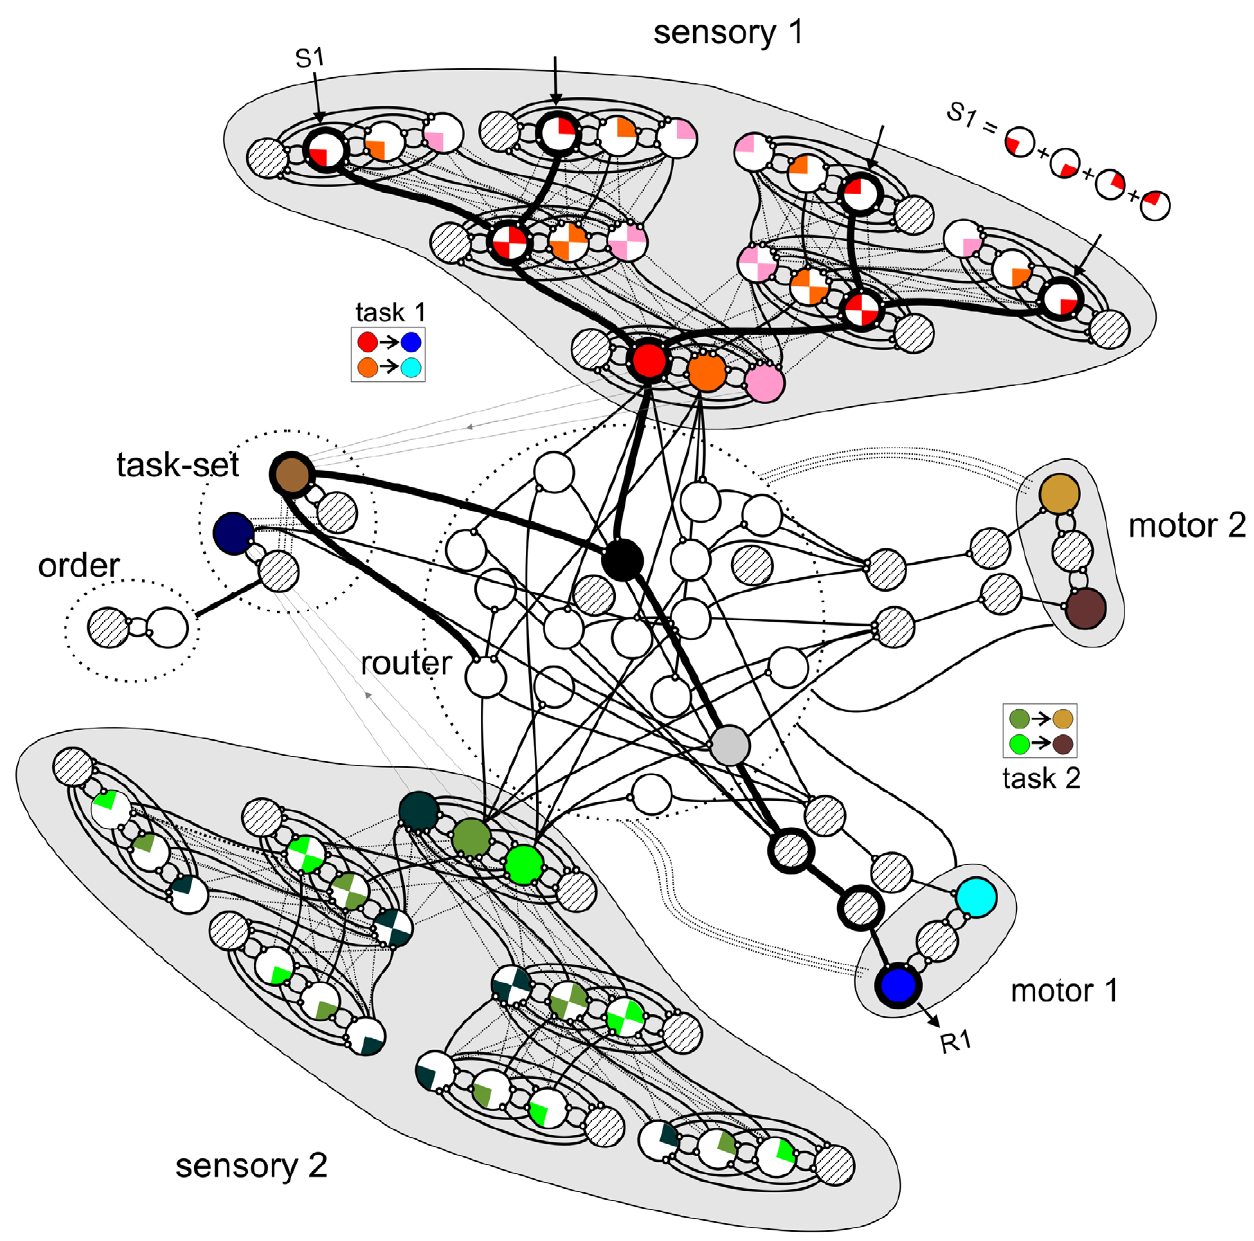
Figure 1. Network architecture. Schematic of the spiking neuron network model. Each population, represented with a circle, contains between 80 and 640 neurons. Circles with diagonal textures indicate inhibitory populations and all other circles indicate populations of pyramidal cells. Whenever two populations of neurons are connected this indicates full connectivity between them. The network includes two sensory modalities (sensory 1 and 2), organized in a hierarchy in which each successive layer receives inputs – mediated by rapid (time constant of 2ms) AMPA receptors - from various populations of the previous layer thus generating progressively more complex receptive fields. Each stimulus (for example, S1) is represented by the co- activation of four specific neural populations in the first layer of the sensory hierarchy. Just for illustration purposes, each stimulus is represented as a solid circle and the different features of this stimulus as parts of this circle, i.e. the 4 red neurons in the first layer represent a stimulus when they are active together. Sensory modules are also connected through non-specific feedback connections mediated by slow (time constant of 100ms) NMDA receptors. Both sensory modalities converge to the router, which is a common integrator. The integrator neurons feed back to the sensory neurons, generating recurrent activity which can maintain and amplify sensory information. Integrator neurons connect to response neurons and thus route information from sensory to motor neurons. Subsets of the neurons in the router link information from stimuli to responses in a flexible manner. Router neurons also receive input from task-setting neurons and thus act as detectors of the conjunction of the relevant task and the appropriate stimulus. The circuit involved in mapping S1 to R1 of Task 1 as well as the task-setting of Task 1 is emphasized in bold. Response execution is triggered by a set of bursting neurons that signal a threshold-cross of the input received from the routing neurons that integrate information. Response neurons feed back to the router and to inhibit the neurons immediately after the response. This inhibition prevents perseveration and is required to stabilize the network in a single response mode. In a typical PRP experiment, which we model here, subjects are instructed to respond to both tasks as fast as possible in a particular order. To enforce this response order in the network we organized the task-setting neurons in a hierarchy [52] in which the neurons coding for Task 1 and Task 2 are controlled by a switch composed of task-order units (see Materials and Methods section for a detailed